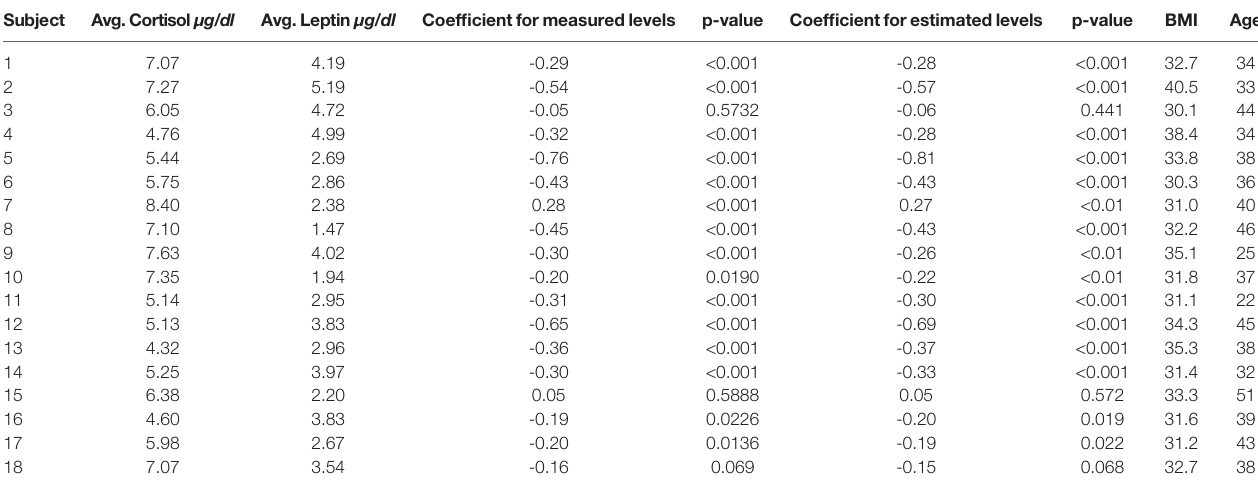
TABLE 1 | Comparison of spearman